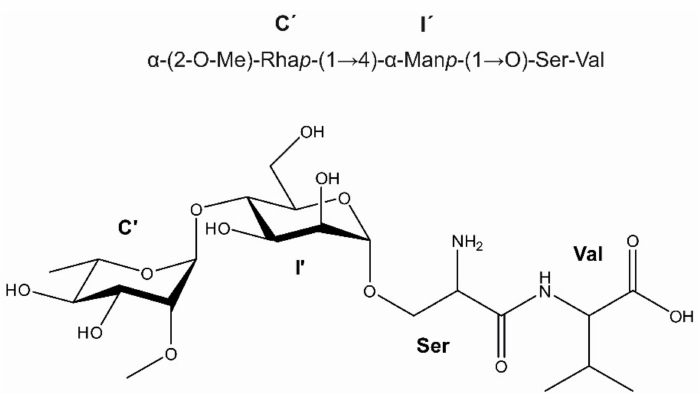
Figure 6. Structure of the B. fragilis ∆ BF4306 glycopeptide f28, revealing the glycan-peptide linkage. The absolute configuration of the rhamnose unit C‘ remains to be firmly established and has only been tentatively assigned to L -configuration.